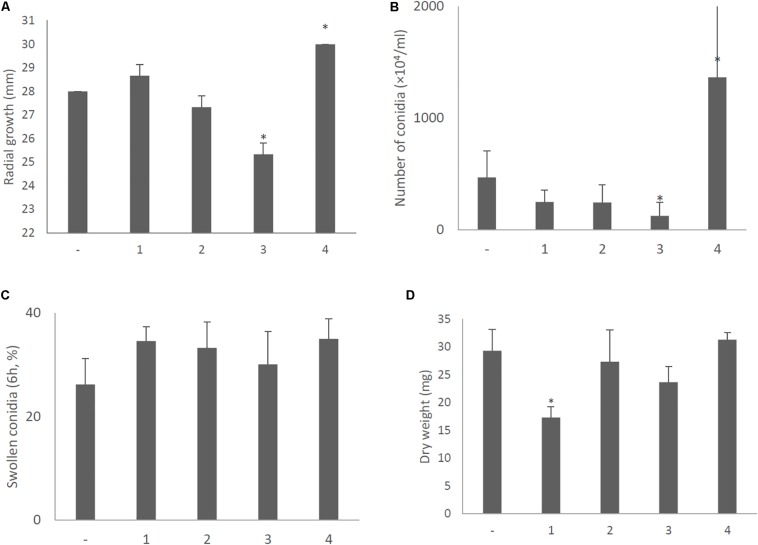
Morphological comparisons of the AfuCV41362 ORF-expressing KU strains. (A) Radial growth of colonies by ORF-expressing KU strains. (B) The number of conidia formed by the strains at 24 h after starting point inoculation. (C) Percentages of swelling (6 h, D conidia of the strains). (D) Mycelial growth. Growth was quantified by measuring dry weights of mycelia at 24 h after starting incubation of conidia. Data are presented as mean ± SD of three independent experiments. ∗P < 0.05, by one-way ANOVA, Dunnett’s test.